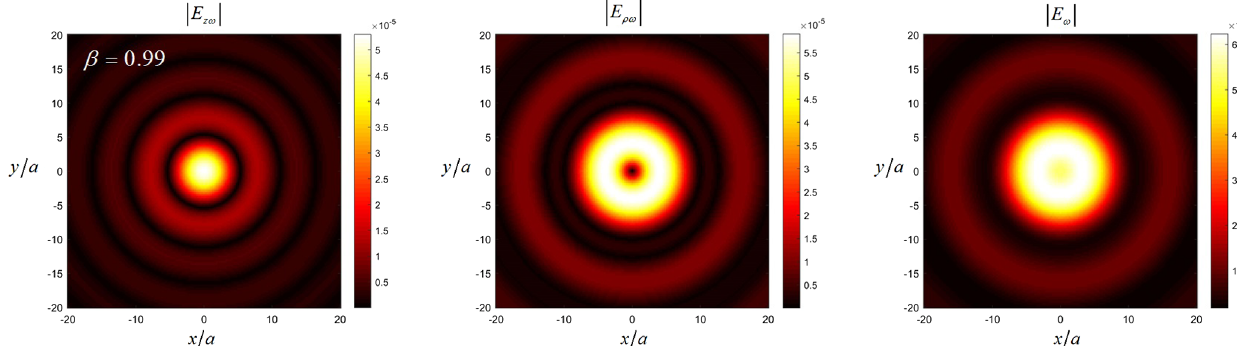
FIG. 3. Two-dimensional field distribution (electric field per unit frequency) over xy -plane ( x and y are normalized by channel radius a ) for symmetrical case r 0 ¼ 0 , β ¼ 0 . 99 and z ¼ z (focal plane). Other parameters are the same as in Fig f